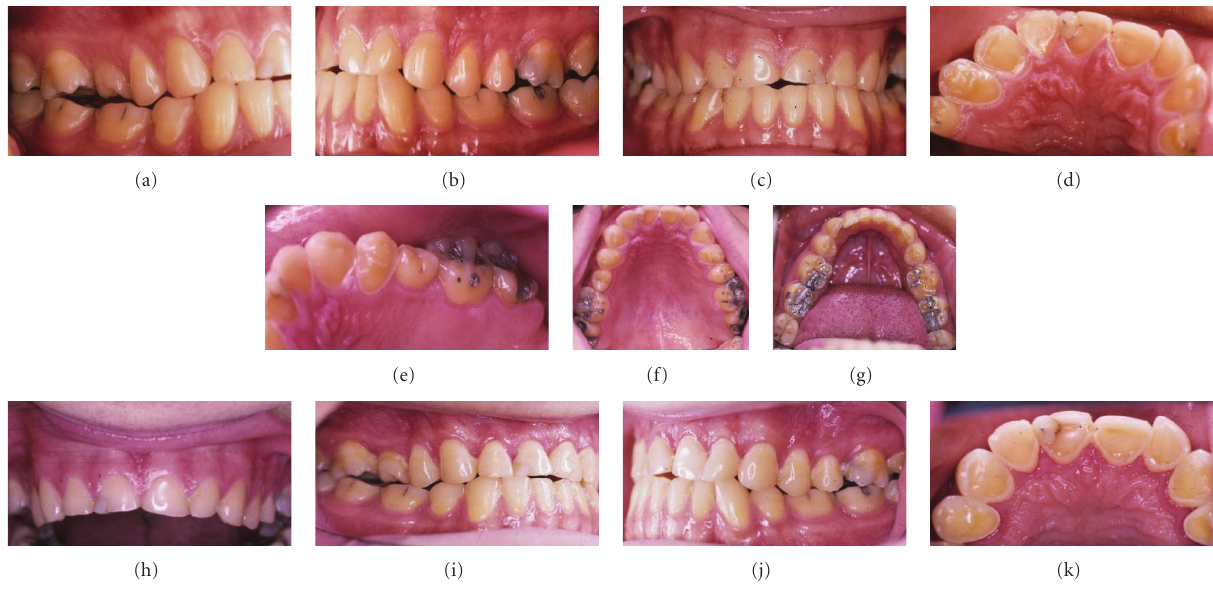
Figure 12: In (a–e), the teeth are smaller, with shiny surfaces. The full intercuspal occlusion shows spaces from reduction of cuspal height; the incisors, canines, and premolars are eroded palatally and worn down with attrition. (f, g) are occlusal views of Upper and Lower arches. Loss of occlusal tables from attrition and erosion is evident on the premolars and molars; there is occlusal saucerisation of cusps on the first and second molars. Figure 12(h) is a pre-op view of upper anteriors. Note short vertical height of incisors and loss of buccal enamel on all upper teeth. Figures (i, j, k) are healing post-op views after clinical crown lengthening. The central incisors are longer, the premolar palatal cusps are lost, and the palatal aspects show a clear palatal step where enamel has eroded away. This erosive pattern involves the buccal surfaces of the upper teeth and is decidedly di ff erent when compared to the erosive patterns encountered with GORD [17].